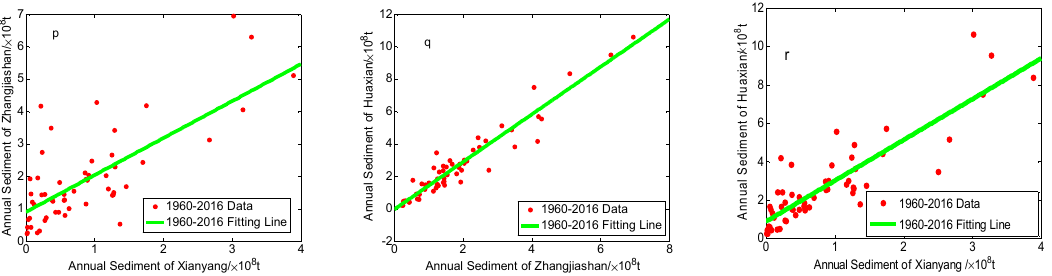
Figure 5. Correlation of runoff ( a – i ) and sediment ( j – r ) yields of the Three Stations.